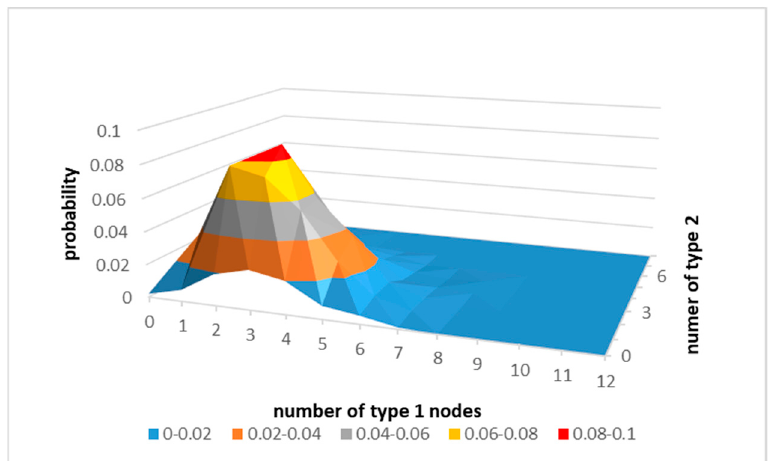
Figure 1. The simulated probability density distribution of antecedents of the node as a function of the number of “type 1” and “type 2” nodes in random graphs.